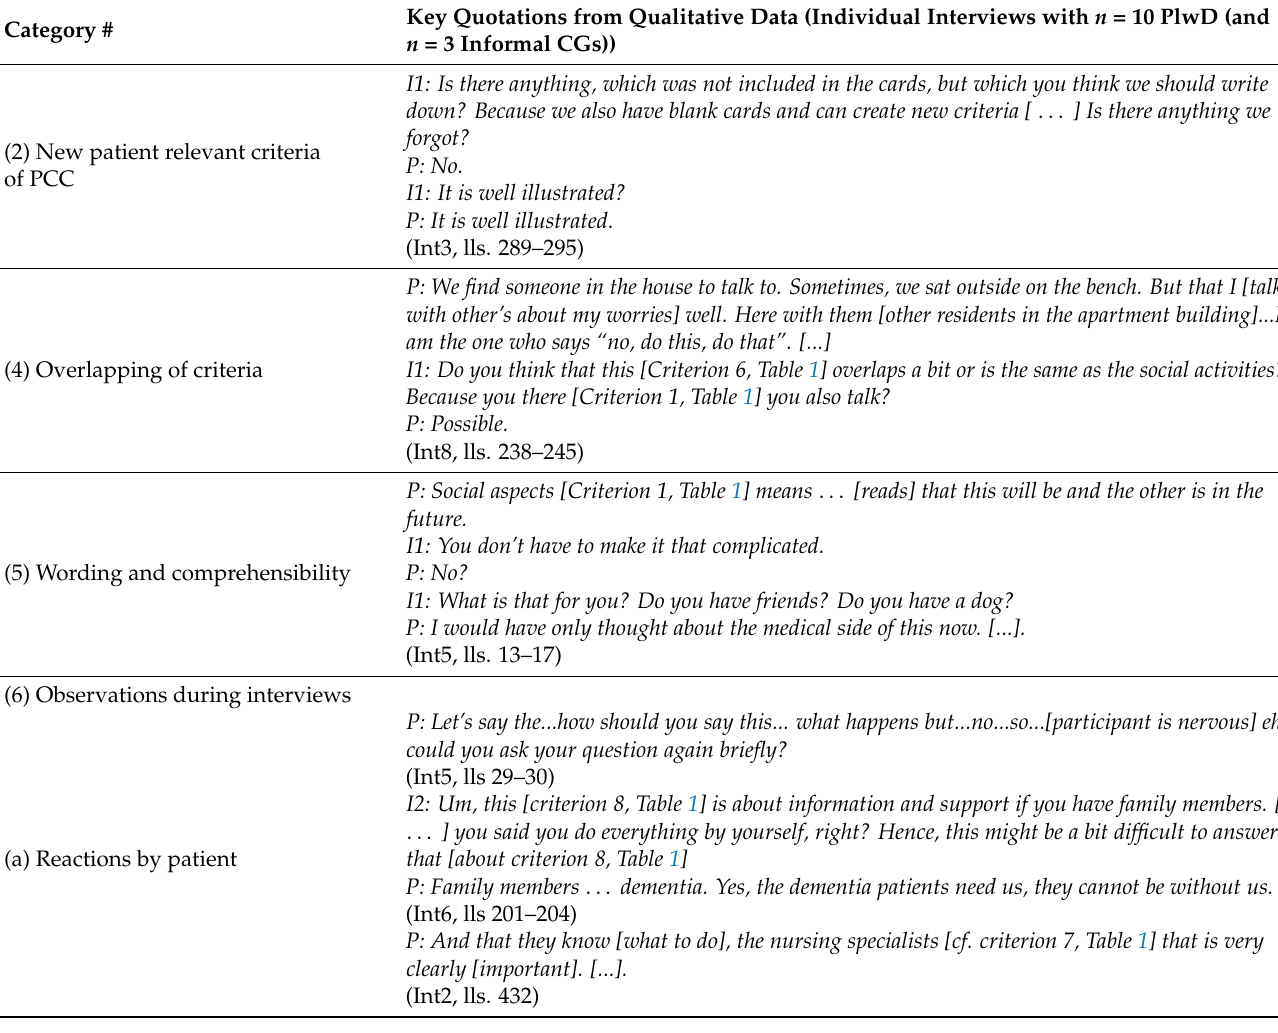
Table 4. Results: Key quotations for categories 2, 4–6. Key Quotations from Qualitative Data (Individual Interviews with n = 10 PlwD Category #